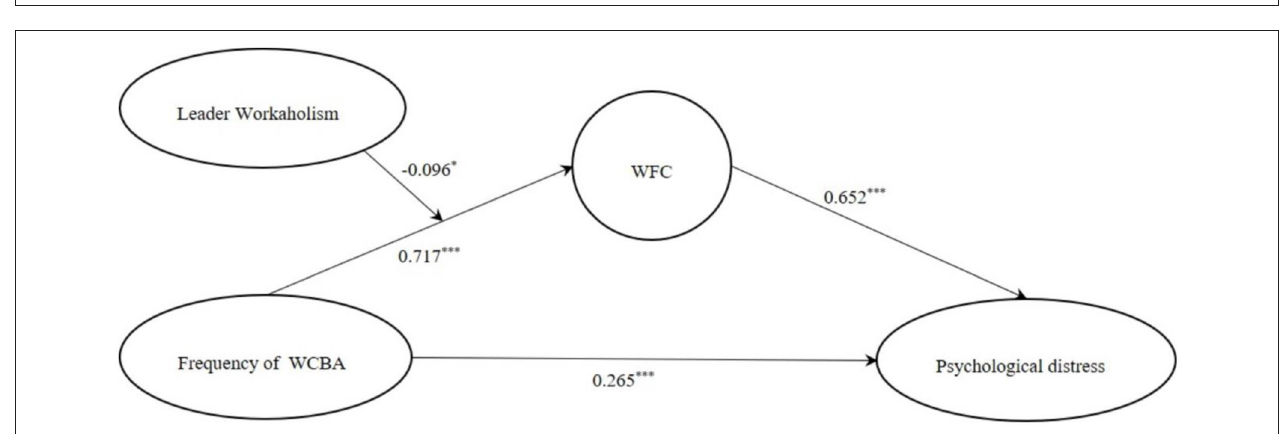
FIGURE 3 | Model path diagram based on the duration of WCBA.